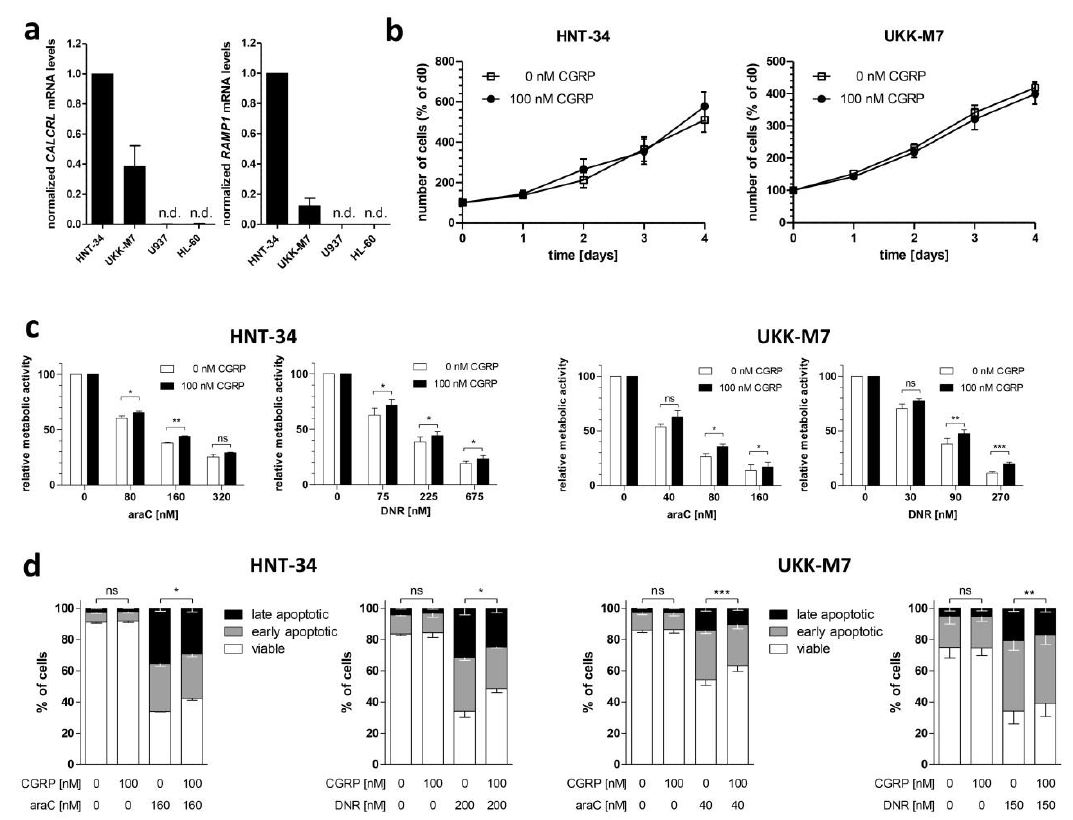
Figure 2. CGRP increases the resistance of receptor positive human AML cell lines to drugs used in the treatment of AML. ( a ) Expression of CALCRL and RAMP1 in the human myeloid cell lines HNT-34, UKK-M7, U937, and HL-60 was determined by qRT-PCR. Normalization to β -2-microglobulin mRNA levels and calibration to HNT-34 was performed using the ∆∆ C T method. n.d., not detectable. Means + SEM from 3 biological replicates. ( b ) Proliferation of HNT-34 and UKK-M7 cells in the absence or presence of 100 nM CGRP. Means +/ − SEM from 3 biological replicates. ( c , d ) CGRP protects HNT-34 and UKK-M7 cells from araC- and daunorubicin (DNR)-induced apoptosis. Cells were pre-incubated with or without 100 nM CGRP for 1 h prior to addition of the indicated concentrations of cytostatic drugs. Means +/ − SEM from 3–5 biological replicates. ns, not significant, * p < 0.05, ** p < 0.01, *** p < 0.001, paired Student’s two-tailed t-test. ( c ) CellTiter-Glo metabolic activity assay. ( d ) AnnexinV / DAPI assay.